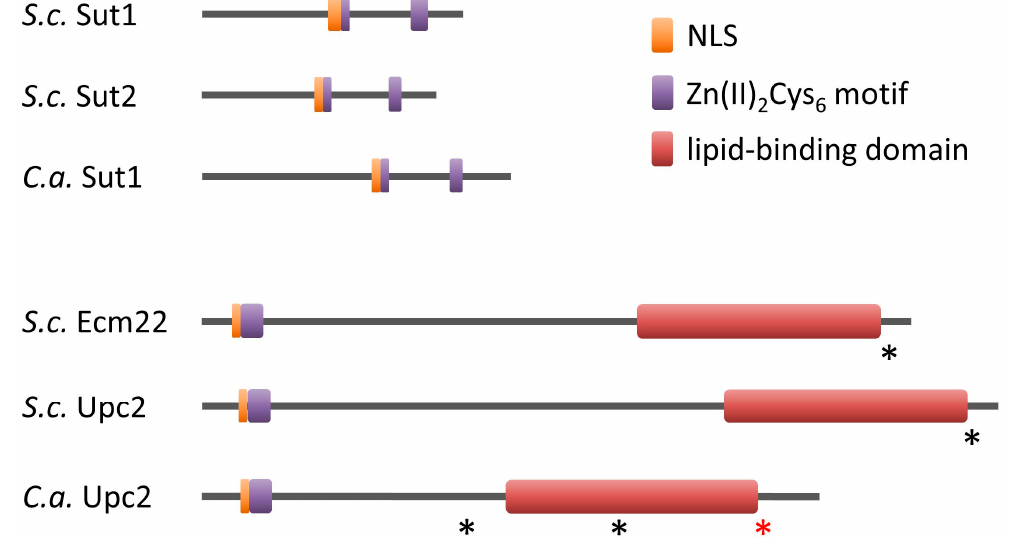
Figure 2. Domain structures of Ecm22, Upc2, Sut1 and Sut2. Shown are proteins from the budding yeast S . cerevisiae ( S.c .) and C . albicans ( C.a .). Asterisks denote gain-of-function mutations of Ecm22 and Upc2. The red asterisk of C . albicans Upc2 represents several distinct amino acid substitutions between residue 642 and 648.